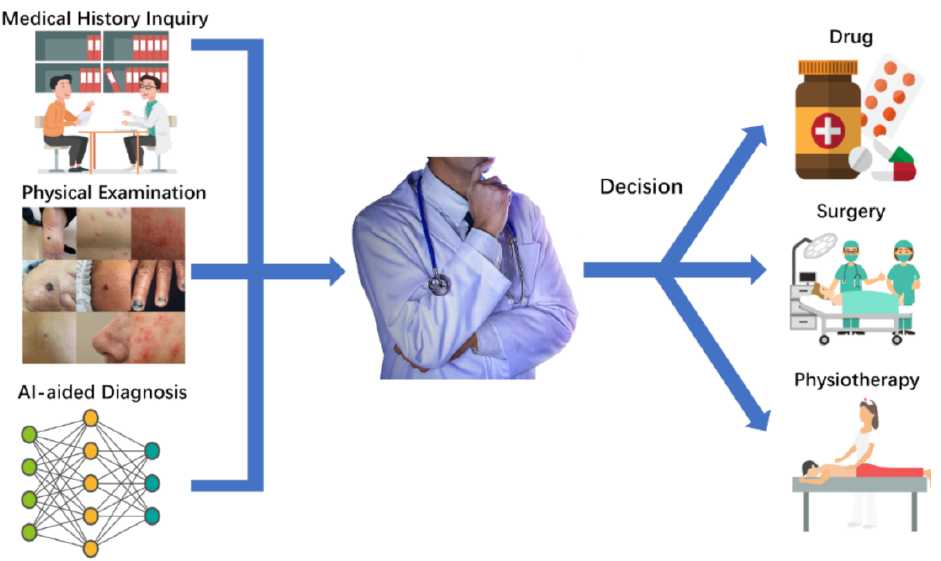
Figure 5. The schematic diagram shows the hypothetical use of machine learning algorithms to help dermatologists diagnose lesions to make appropriate clinical decisions. An emerging AI model CNN can help non-expert clinicians narrow the range of differential diagnosis and provide appropri- ate